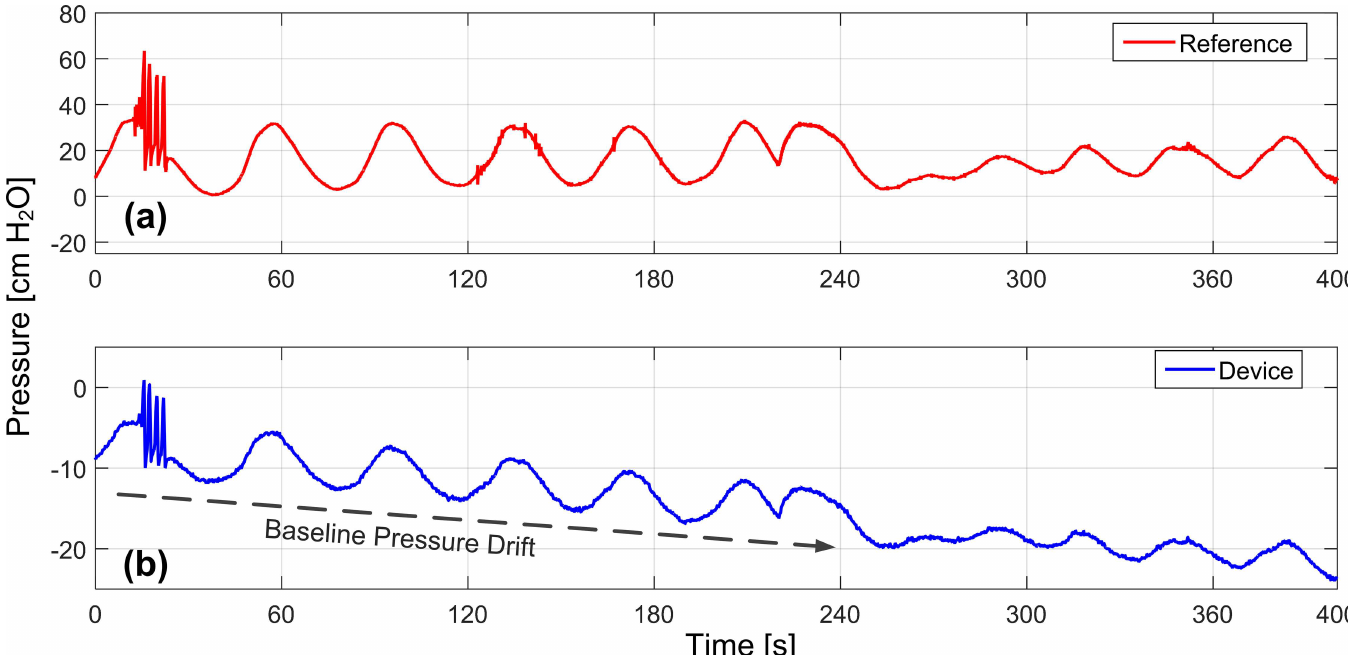
Fig 3. Suburothelial Baseline Drift. A slow drift of approximately 2 cm H 2 O per minute was noted betweenvesical reference (a) and suburothelialpressure monitor (b) recordingsin the